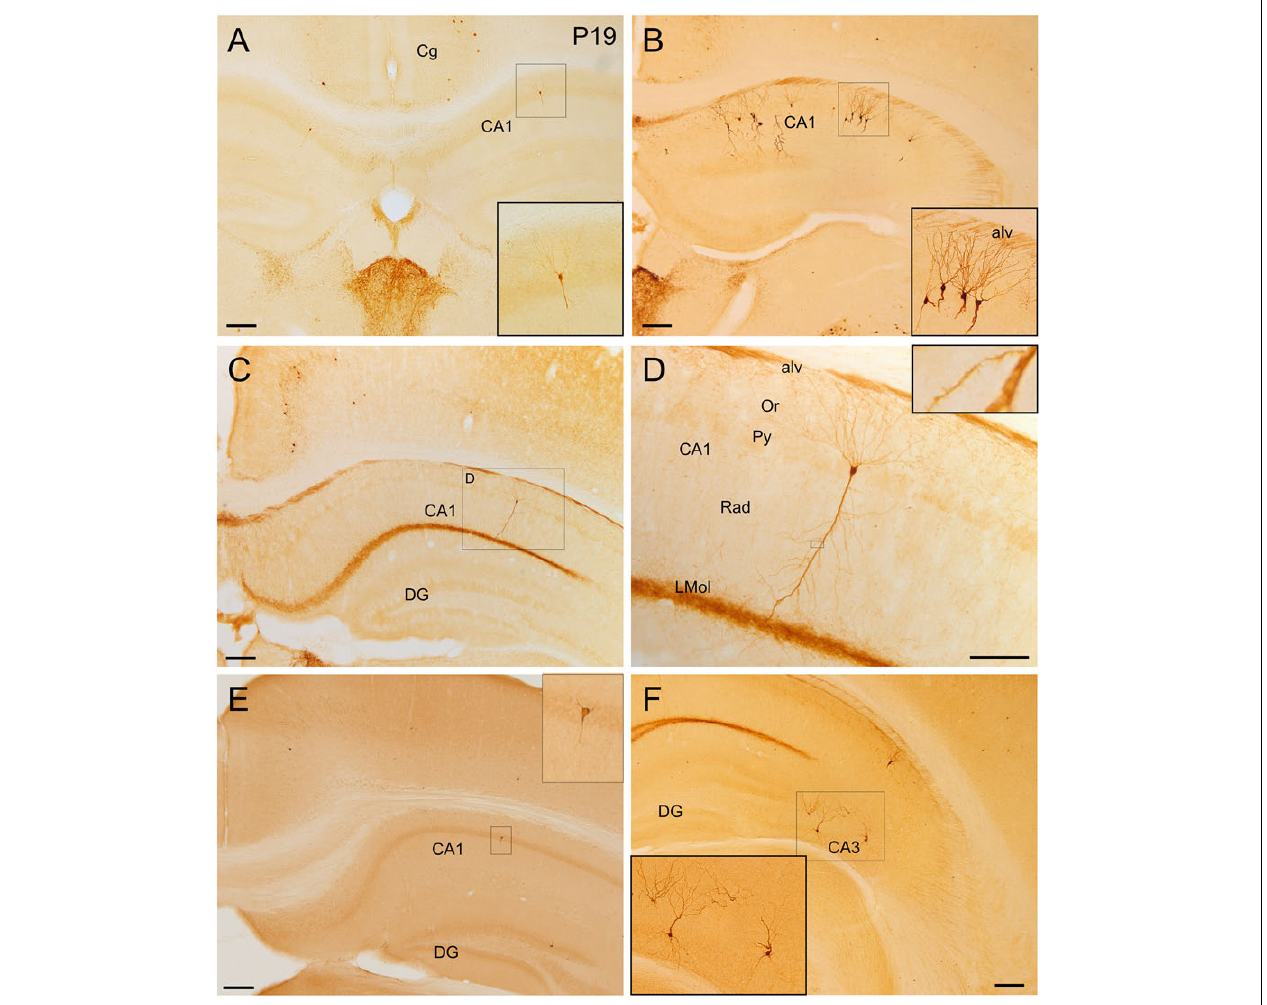
FIGURE 9 | GFP and HA immunoreactivity in the postnatal and adult hippocampal formation. Images of frontal brain sections of postnatal (A) and adult (B–D,F) Otp-eGFP mice and adult Otp-Cre; Rpl22-HA mice (E) , showing GFP or HA immunoreactive cells in the hippocampal formation. In particular, the images show cells in different CA subfields (details in insets). In the Otp-Cre; Rpl22-HA, labeled cells are observed in similar positions of the hippocampal formation to those in the Otp-eGFP. In the CA fields, cells are found in the pyramidal cell layer and show a pyramidal-like morphology, with spiny dendrites [inset in panel (D) ]. Basal and apical dendrites traverse the strata and are in contact with labeled axons of the alveus (alv) and stratum lacunosum moleculare (LMol). See text and abbreviation list for more details. Scale bar: panels (A–C,E,F) = 200 µ m. Panel (D) = 100 µ